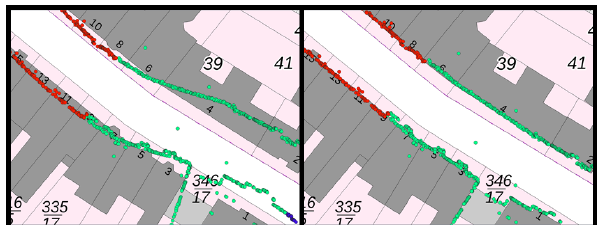
Figure 8. Excerpt of the point cloud with two segments (red) and (green). Small segments are influencing the result. Results without a pre-transformation of the point cloud (left) and with a pre-transformation (right) are depicted.